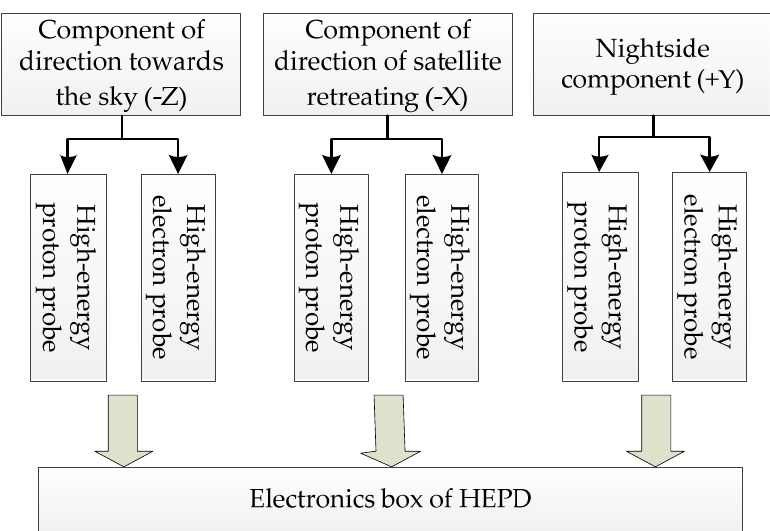
Figure 1. Diagram of high-energy particle detector system composition.